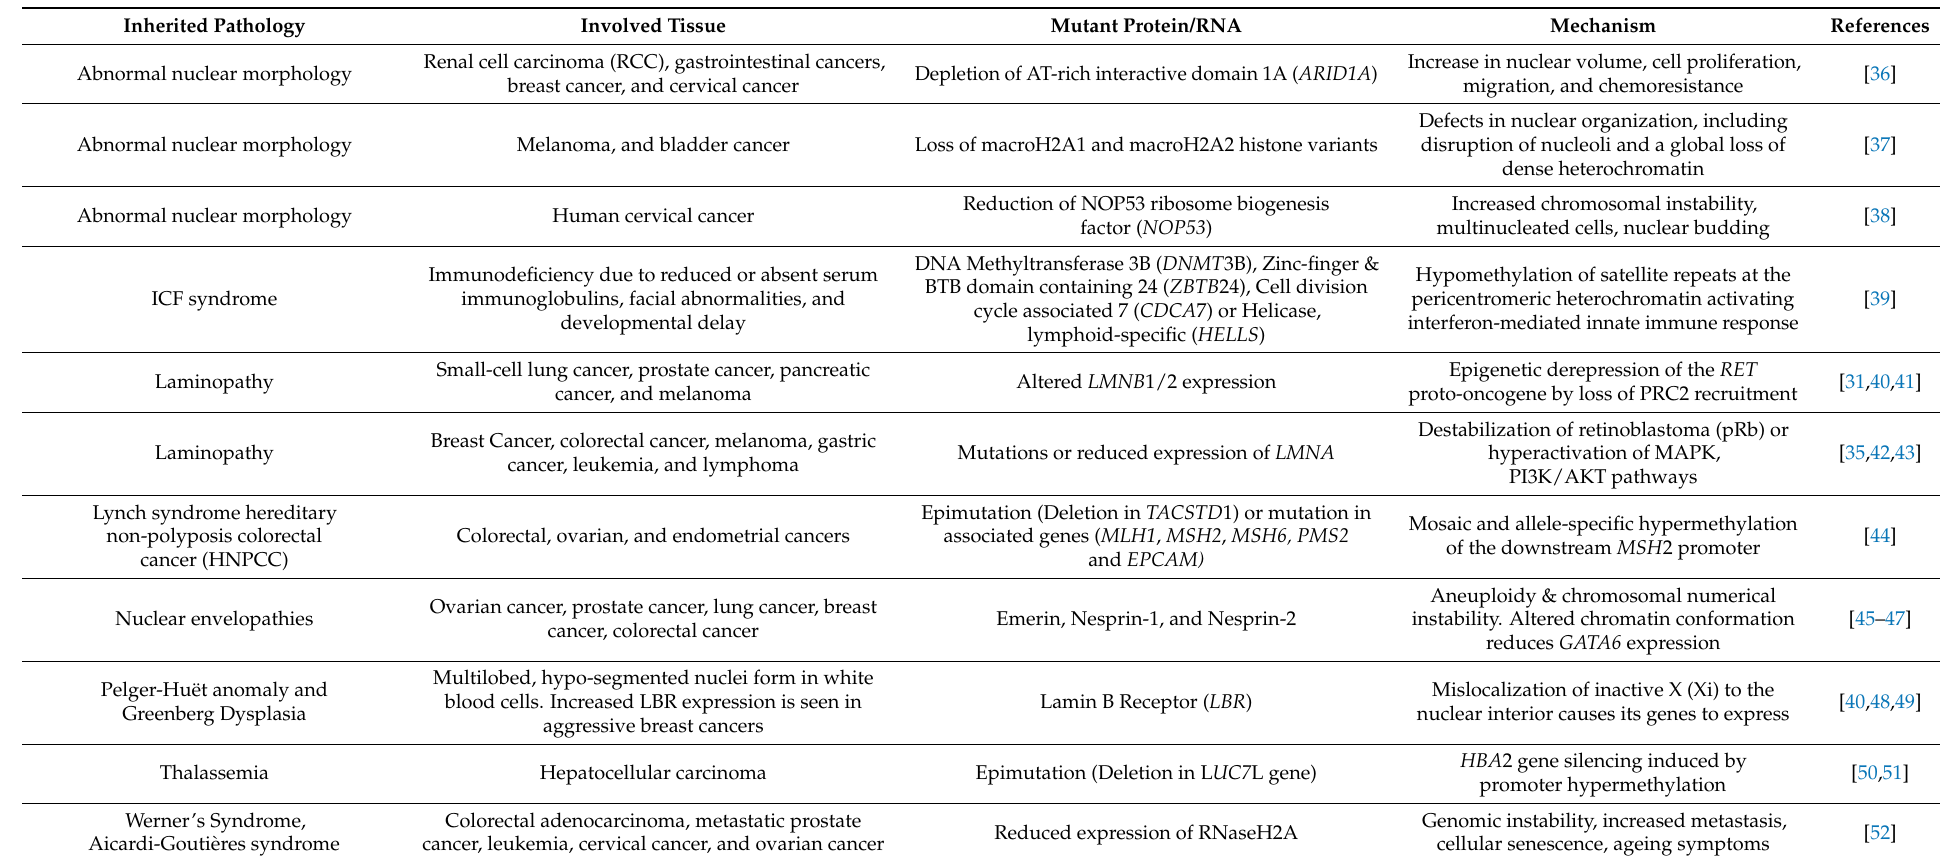
Table 1. Inherited pathologies due to nuclear or chromatin disorganization and their association with cancer